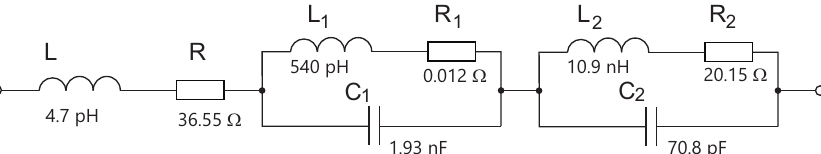
Figure 8. Equivalent circuit of converter ( radiator +